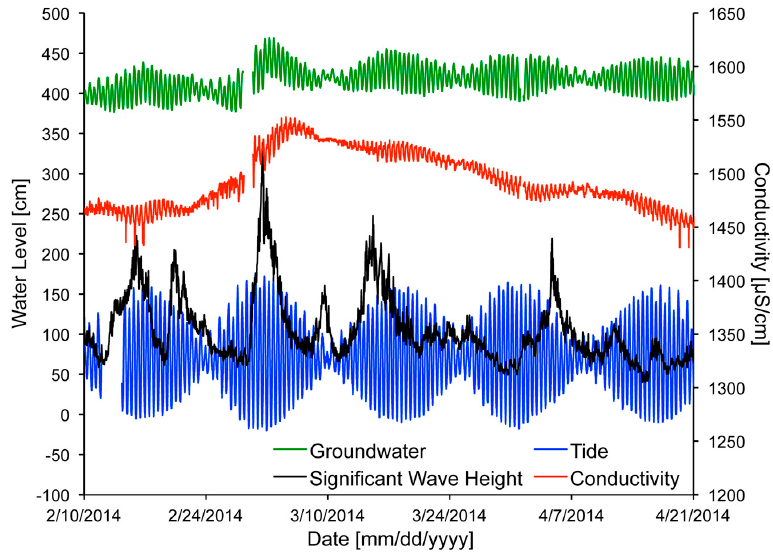
Figure 8. Observed variations in conductivity and ground water level in well A1 following an island overwash event driven by increased significant wave height during 2–3 March 2014.